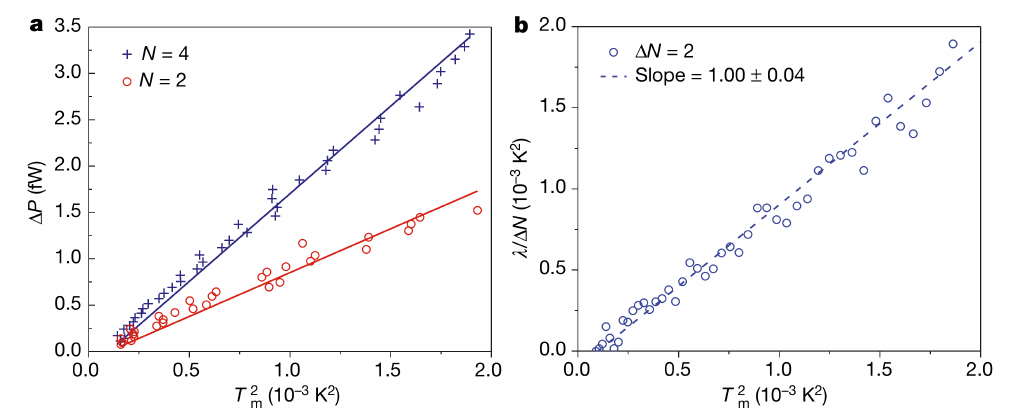
Figure 8: Measurement of the thermal current for ν = 1 / 3 [ 38 ] : (a) Power dissipa- tion ∆ P as a function of T 2 for N = 2,4 active edges (currents), compared with the theoretical prediction (118) for one chiral mode; (b) Difference of power dissipations for N = 4 and N = 2 edges, and linear fit for measuring the slope | c − ¯ c | in (119).